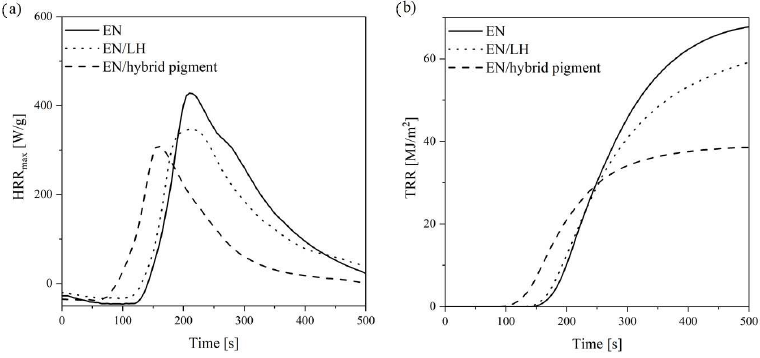
Figure 14. HRR ( a ) and THR ( b ) curves of EN, EN/LH, and EN/hybrid pigment copolymer. Table 4. Flammability results recorded using a cone calorimeter.